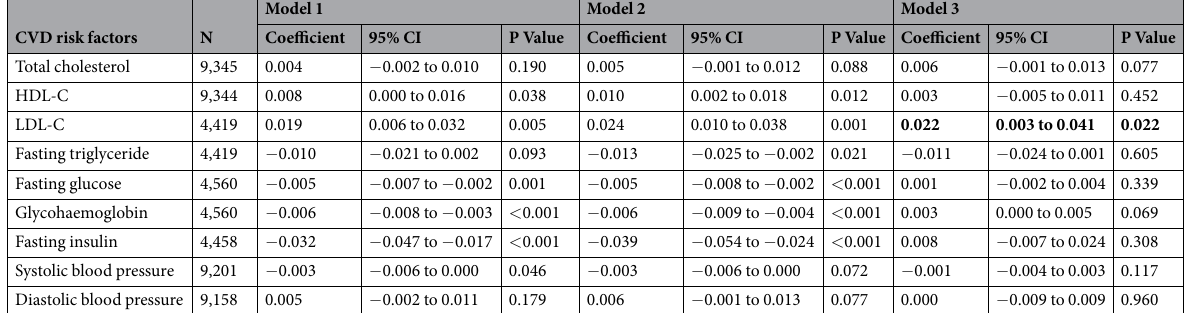
Table 2. Multivariable associations of serum lead with cardiovascular risk factors in US adolescents 1999–2012. Model 1—age and gender adjusted; model 2—as model 1 plus ethnicity, PIR; model 3—as model 2 plus waist circumference, serum cotinine, physical activity and NHANES cycles. CVD, cardiovascular disease; CI, confidence interval; HDL-C, high-density lipoprotein cholesterol; LDL-C, low-density lipoprotein cholesterol; PIR, poverty index ratio.